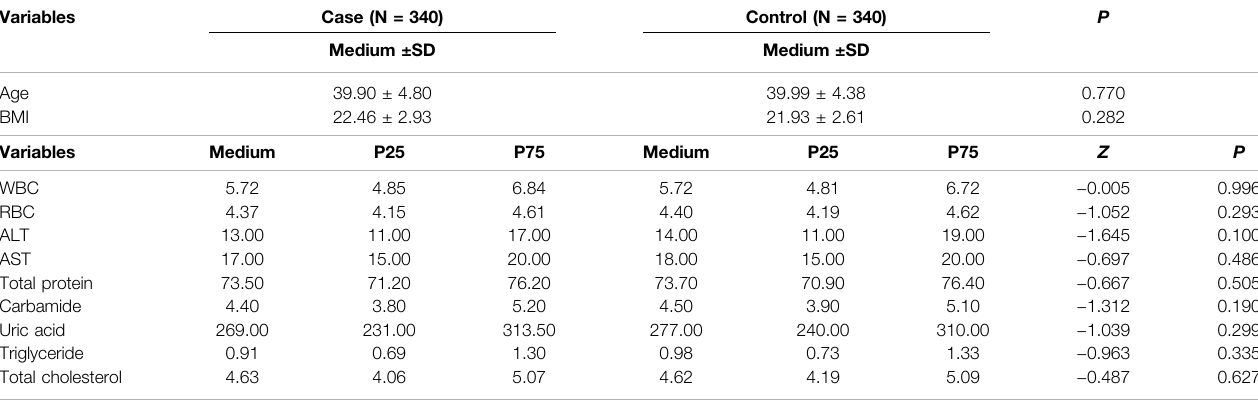
TABLE 2 | The information of selected variables of validated ULs patients and